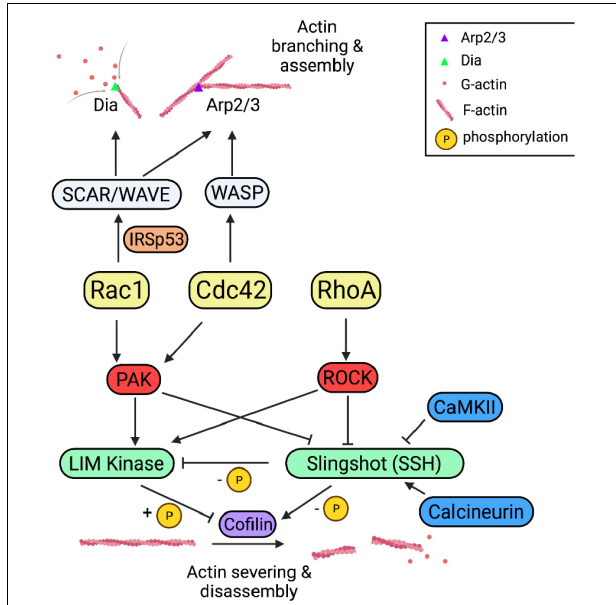
FIGURE 3 | Rho GTPase signaling pathways in actin dynamics and synaptic function. Rac1, Cdc42, and RhoA regulate actin dynamics either through cofilin or Arp2/3 complex pathways. Rac1/Cdc42 and RhoA activate PAKs and ROCKs, respectively, which phosphorylate and activate cofilin kinase LIMKs and inhibit cofilin phosphatase SSH, both leading to inactivation of cofilin thus reduced actin disassembly. Rac1 and Cdc42 promote actin assembly through the Arp2/3 complex and the formin-related protein (Dia) via WAVE and WASP,